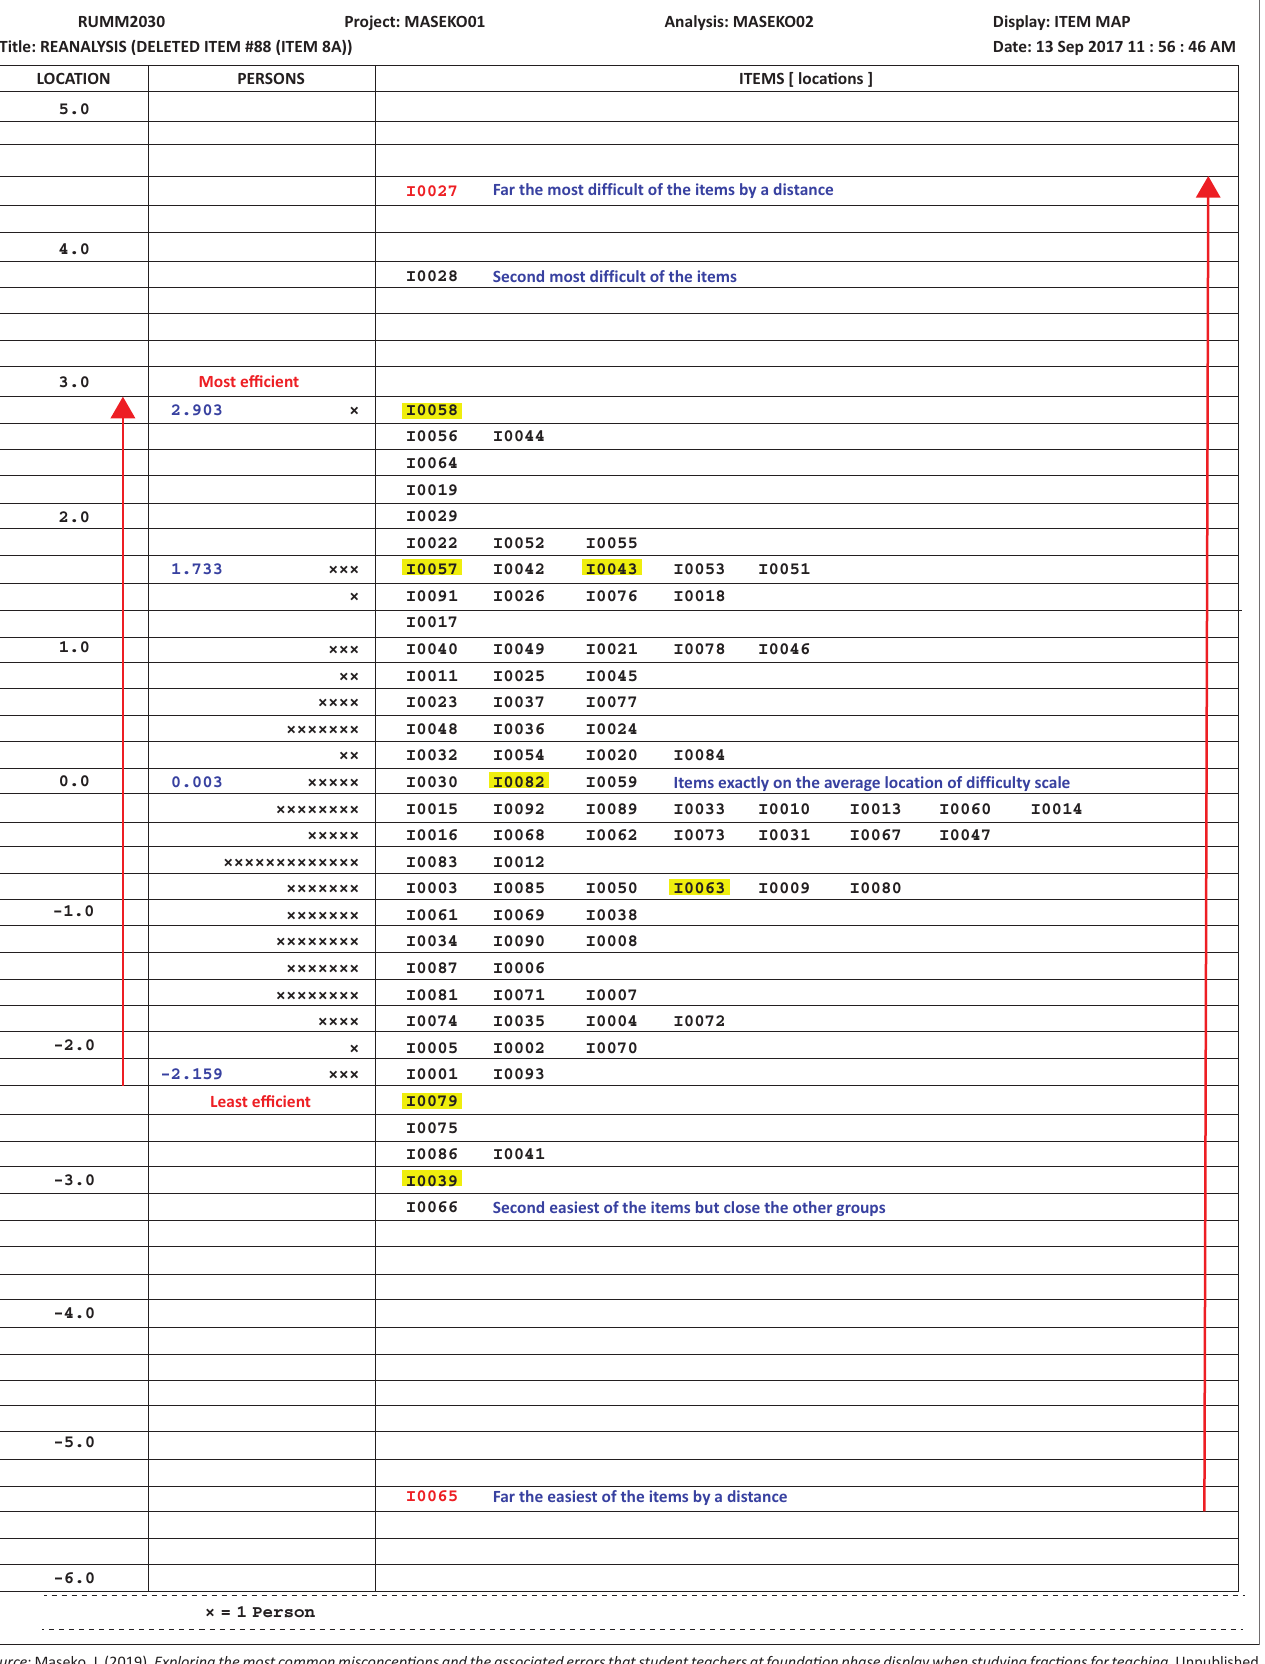
FIGURE 1: Rasch model – Person-item original